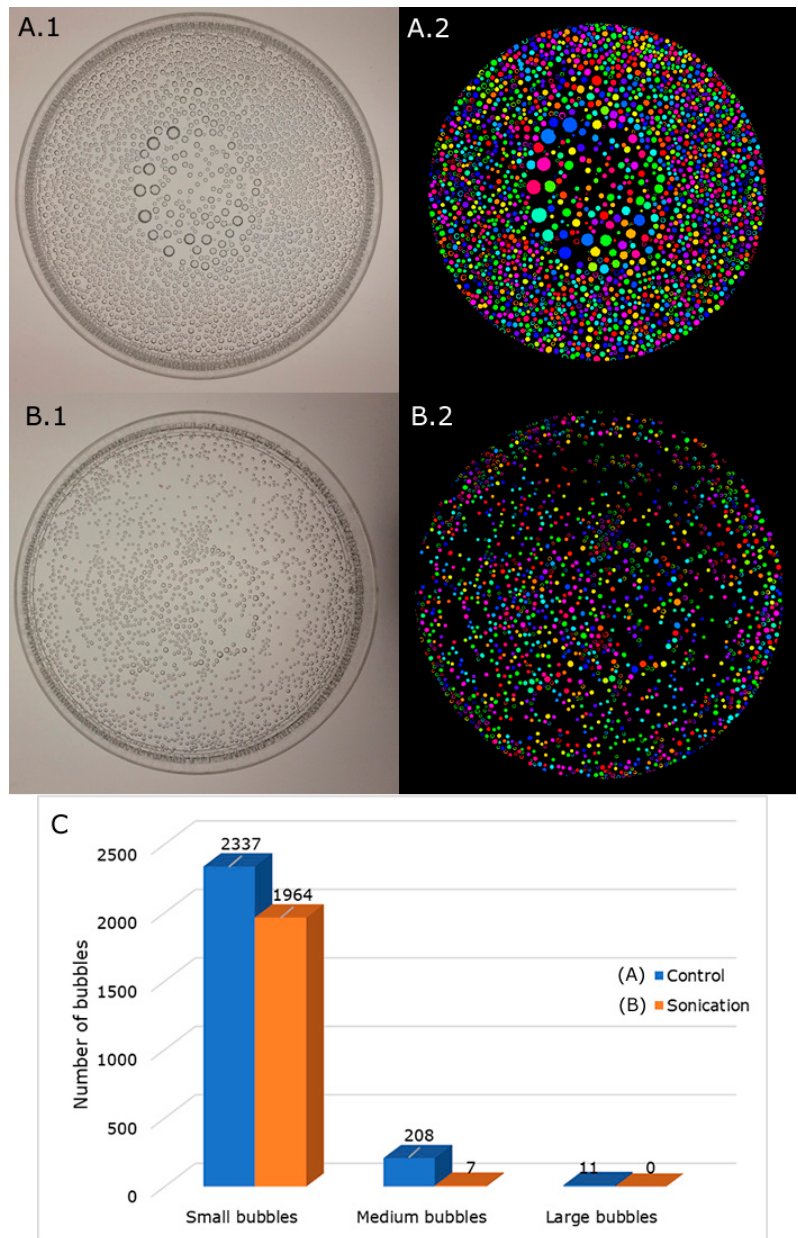
Figure 3. Bubble analysis of one replicate of ( A ) control (SP) and ( B ) sonication treatment (SPS) samples, where ( A.1 ) and ( B.1 ) are images taken using the lightbox, and ( A.2 ) and ( B.2 ) images processed using the algorithm to detect, count, and measure bubbles using Matlab ® R2019a; different colors represent different bubble sizes. ( C ) shows the bubble size and bubble size distribution (small, medium, large bubbles) of both ( A ) and ( B ). SP and SPS are samples used, defined in Table 1.